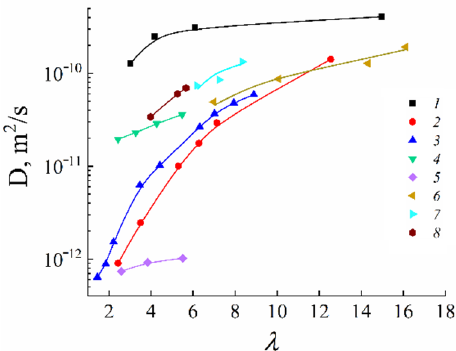
Figure 23. Diffusion coefficients of water molecule dependence on the moisture content for sulfonate cation-exchange resin MF-4SC (1–4) and carboxylic F-4CF (5–8) perfluorinated membranes in various ionic forms. Membrane ionic forms: (1, 5) H + , (2, 6) Li + , (3, 7) Na + , (4, 8) Cs + . Adapted from [24,38].